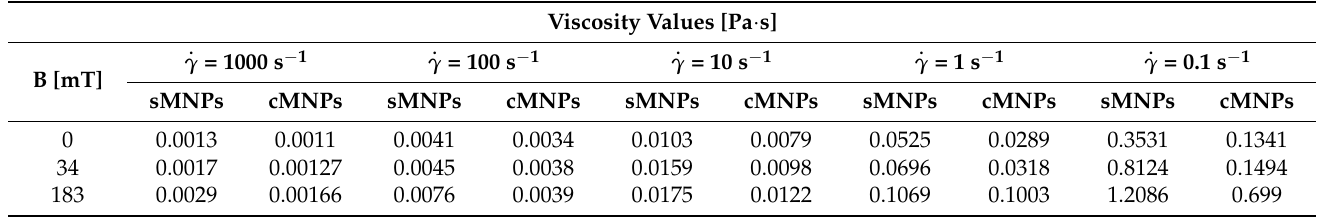
Table 6. Viscosity evolution of the spherical and cubic MNPs for different values of the shear rate for the investigated magnetic